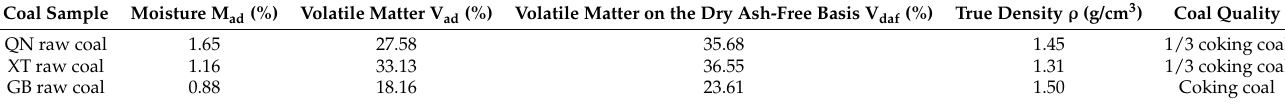
Table 1. Results of proximate analysis on coal